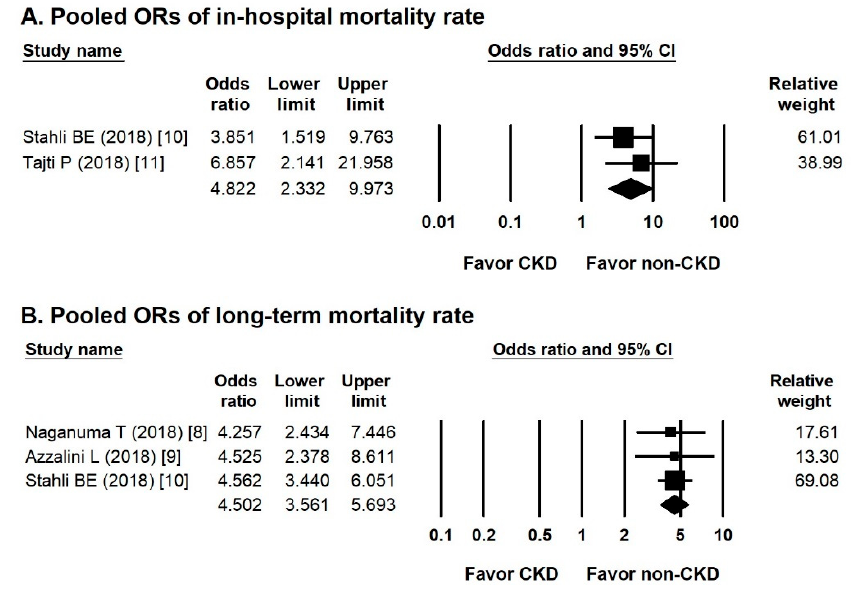
Figure 4. Forest plots of in-hospital and long-term mortality rate. ( A ) Forest plots of the incidence of in-hospital mortality between the CKD and non-CKD group from two studies. ( B ) Forest plots of the incidence of long-term mortality between the CKD and non-CKD groups from four studies.